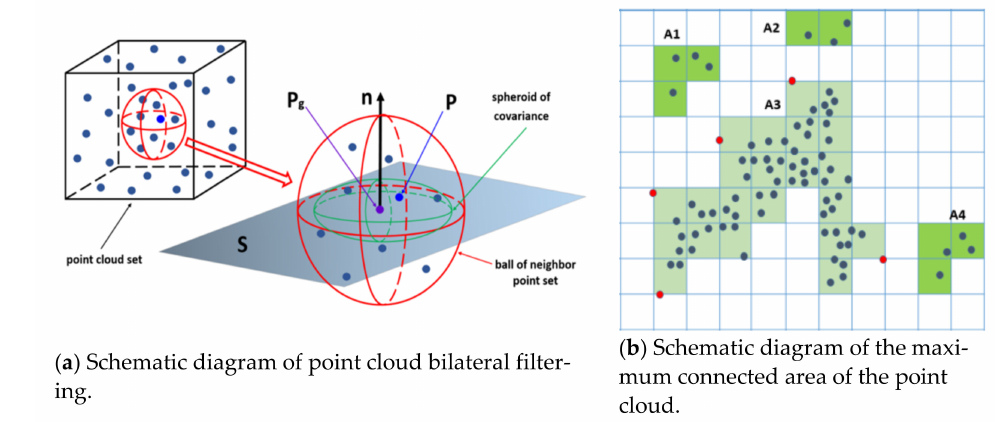
Figure 5. Schematic diagram of two filtering